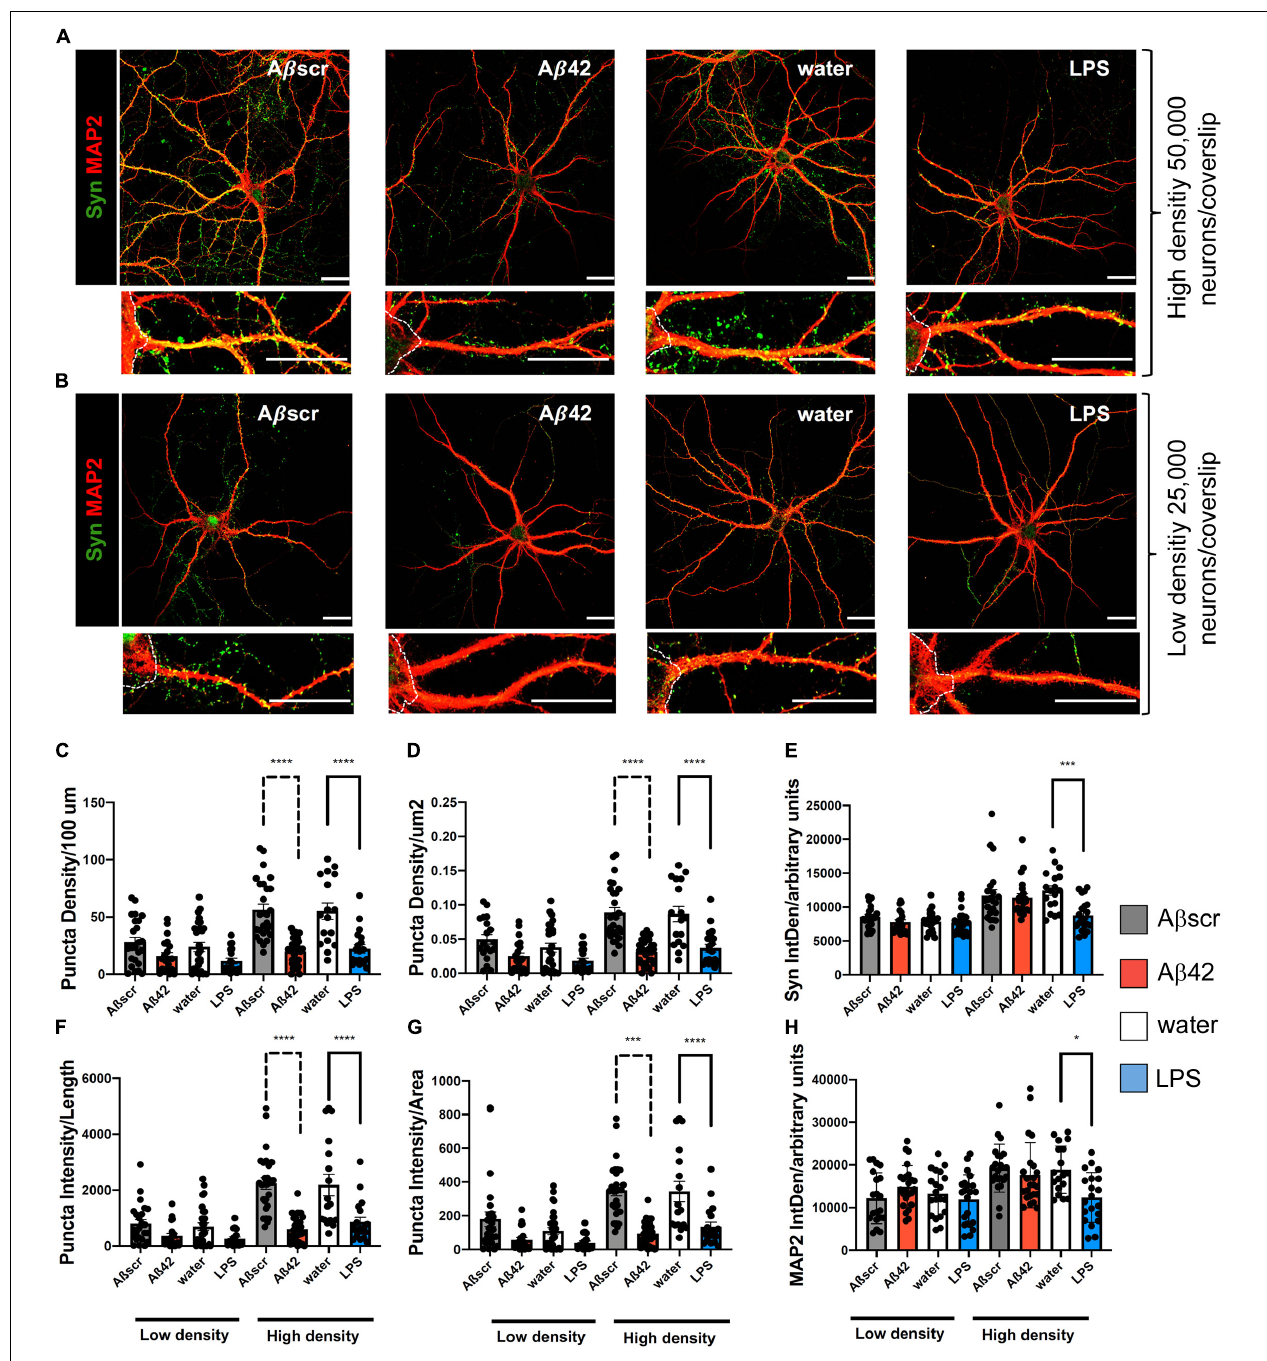
FIGURE 6 | Co-culture of pre-treated primary astrocytes with neurons is associated with synaptotoxic effects. Neurons exposed to reactive astrocytes that were pretreated with LPS (100 ng/ml) or A β 42 (2.5 µ M) show a decrease in synaptophysin Syn+ synaptic puncta as compared to neurons co-cultured with control astrocytes. Water or A β 42scr served as control, respectively (2.5 µ M). (A,B) Representative immunofluorescence staining of synaptophysin (Syn) and MAP2 are shown for each condition, scale bar = 25 µ m. White dotted lines are marking the neuronal soma. High-density plated neurons (A) and low-density plated neurons (B) show a decrease in synaptic punctae upon co-culture with A β 42-pre-treated astrocytes. Puncta density per length (100 µ m) (C) , puncta density per area ( µ m 2 ) (D) , Syn2 signal intensity (IntDen) (A.U.) per field (E) , intensity of Syn+ puncta per length (F) , intensity of Syn+ puncta per area (G) as well as signal intensity of MAP2 (IntDen) (H) in arbitrary units (A.U.) per field were analyzed and compared for each of the different treatment groups of neurons. Different treatment groups are sub-divided in both low- and high-density cultures of neurons with respect to initial plating density. Data is shown as mean ± SEM. N = 3 independent experiments per condition with at least 18 neurons imaged per condition. Per neuron 3 dendritic segments were randomly chosen. Data included technical duplicates per experiment per condition.